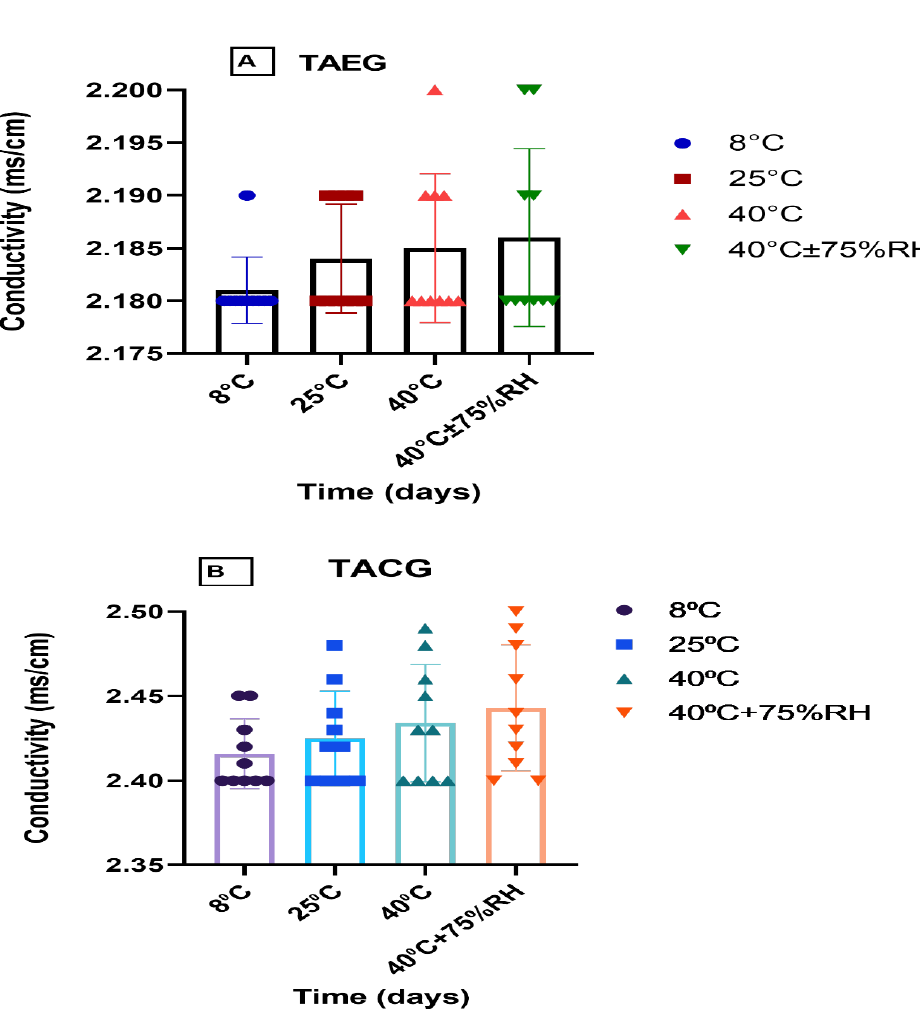
Figure 5. Conductivity of ( A ), TAEG, and ( B ), TACG, kept at different temperatures for the study period of three months. Data are expressed as mean values ± SEM. Insignificant results were produced at 8 °C and 25 °C, 40 °C, and 40 °C ± 75% RH ( p > 0.05).